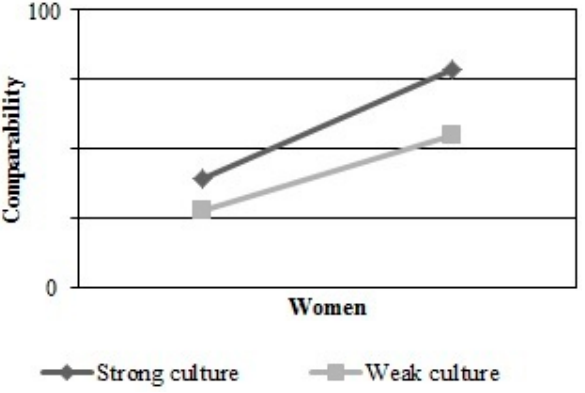
Figure 5. Moderating effect of the cultural context on the link between independent directors and Comparability variable.